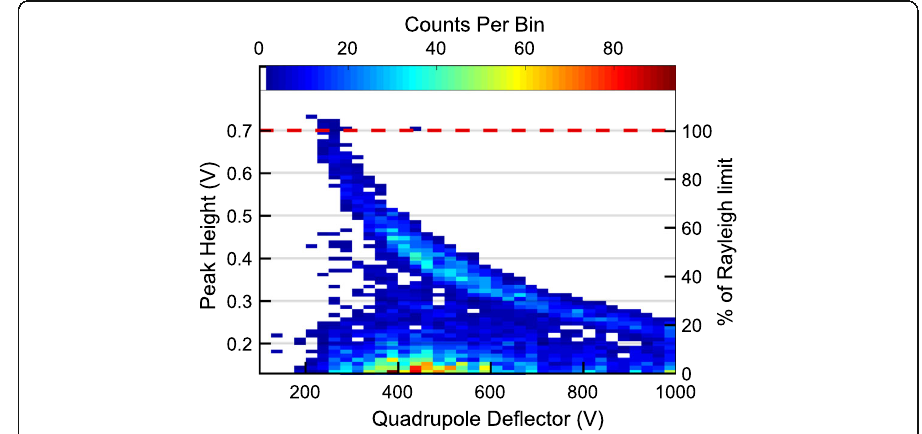
Fig. 7 2D histogram of peak height of 990 nm PSLs arriving at ICD-QD2, plotted against QD potential. ICD-QD2 is not directly calibrated, but the calibration factor can be inferred by reference to another detector (ICD2) . The average number of charges on a 990 nm PSL as measured by ICD2 for particles se- lected with the QD set to 400 V is 17000. This corresponds to a peak height of 0.45 V on ICD-QD2, so the Rayleigh limit of 26500 charges would correspond to about 0.7 V (as shown by the dashed red line). The large number of peaks with heights of <0.2 V are due to particles that have hit the detector pickup instead of passing all the way